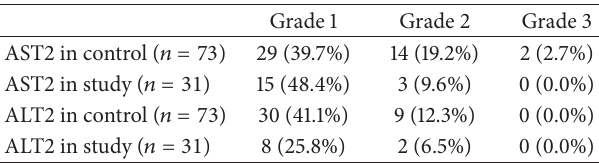
Table 5: The distribution of adverse events of ASL2/ALT2 in the two